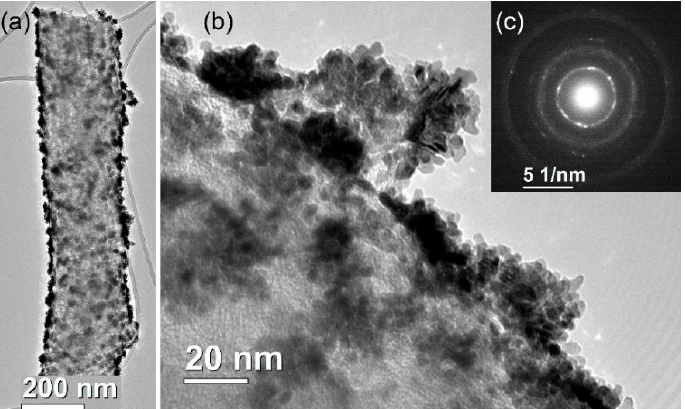
Figure 9. BF TEM images of CNF: ( a ) a general view; ( b ) Pt crystals in the surface layer; and ( c ) the corresponding SAED pattern for sample 6 .